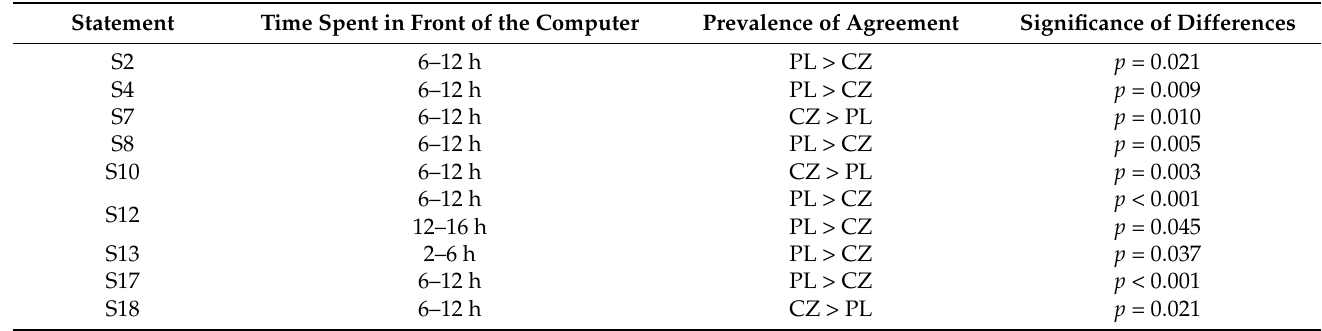
Table 7. Analysis of the prevalence of agreement with statements by nationality and time spent in front of the